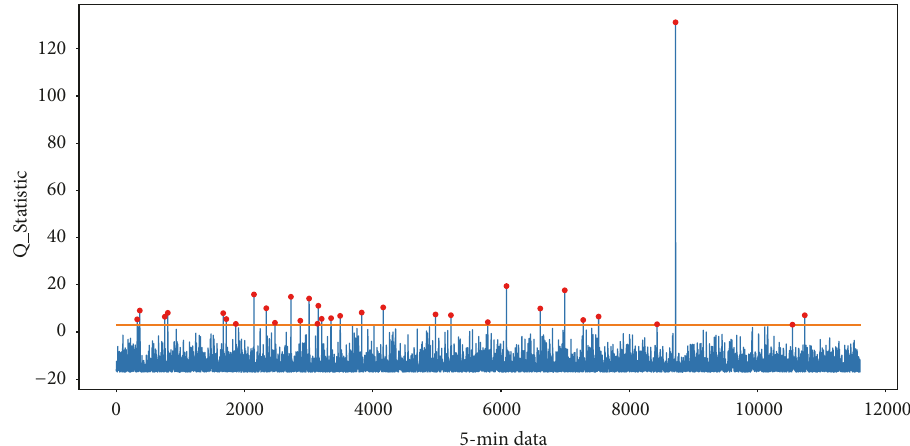
Figure 2: Jumps of the 5-minute interval under the LM test . Eliminate the overnight effect of the 2017 SSE 50 index data. Process the data at a 5-minute sampling interval and calculate the value of the LM statistic. Compared with the yellow horizontal reference line for the significance level threshold in the figure, the 32 points marked red are beyond the normal value